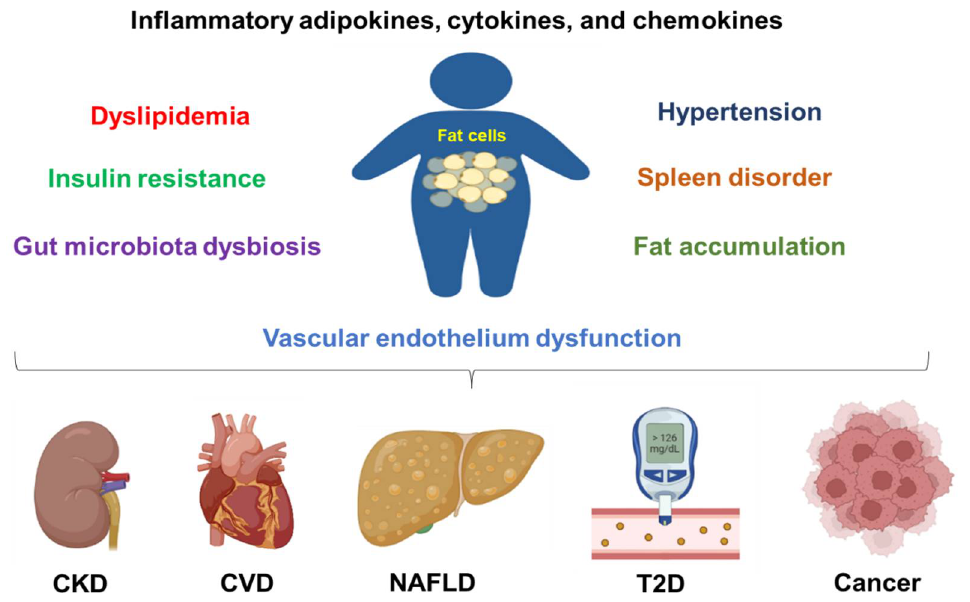
Figure 1. Obesity contributes to chronic disease development and progression. Obesity can cause inflammation, dyslipidemia, insulin resistance, hypertension, fat accumulation, vascular endothelium dysfunction, spleen disorder, and gut microbiota dysbiosis. All these conditions are contributing factors to chronic kidney disease (CKD), cardiovascular diseases (CVDs), non-alcoholic fatty liver disease (NAFLD), type 2 diabetes (T2D), and cancers.